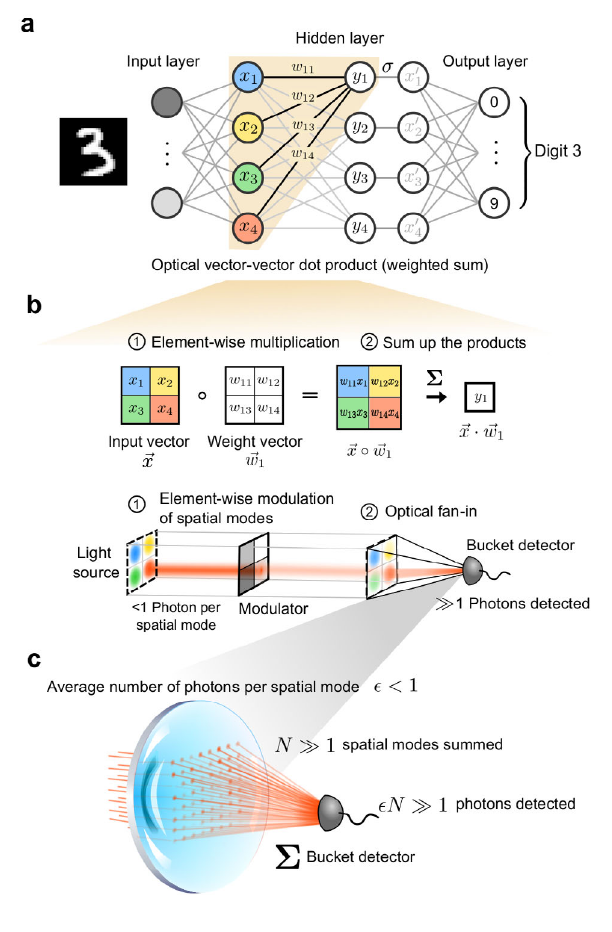
Fig. 1 An optical vector-vector dot product multiplier for characterizing the optical energy consumption of an ONN. a The role of optical vector- vector dot products in executing the forward-pass operation in a fully connected neural network. The weighted sums of neural activations are performed optically (shaded area) and the element-wise nonlinear activation functions are performed electronically. Each neuron in the middle (hidden) layer is color-coded to show the correspondence to their representations in ( b ). The shaded area in the neural-network schematic illustrates the neurons and weights involved in one dot product. b A step- by-step illustration of the computation of optical vector-vector-dot product * * between x and w 1 . The top row shows mathematically abstract operations, and the bottom row shows the corresponding physical operations with optics. “ (cid:1) ” denotes element-wise multiplication between two vectors of the same size. c An illustration of how the optical fan-in operation allows less- than-1-photon-per-scalar multiplication when the vector size is large. A single lens is used to sum the intensities of the spatial modes encoding the element-wise products onto a detector. For suf fi ciently large vector size N , even if each individual spatial mode contains ϵ < 1 photon on average, the total number of photons impinging on the detector ϵ N will be ››